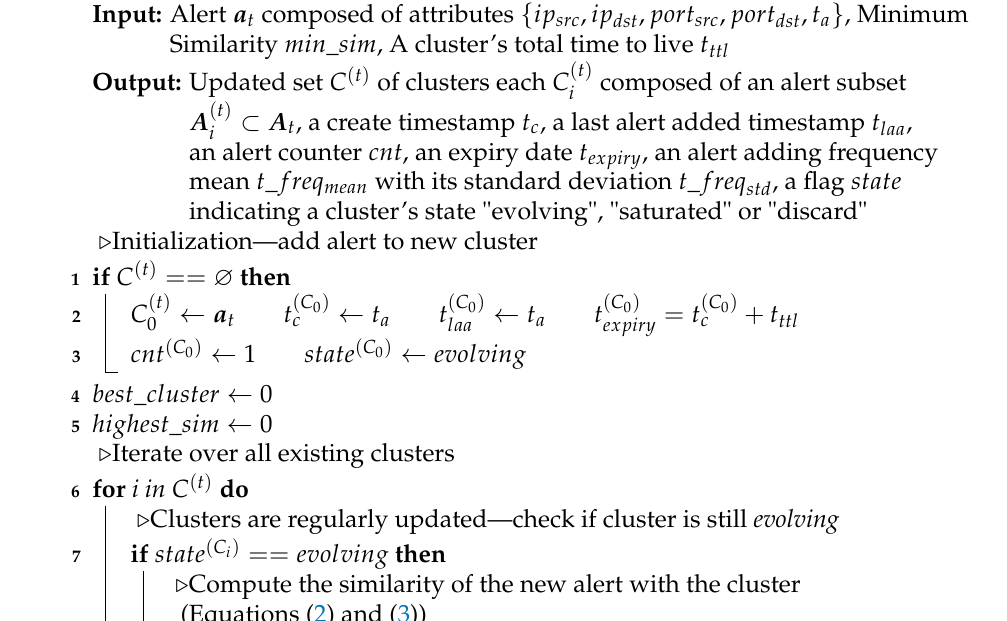
Algorithm 1: The Operation Principle of Streaming Alert Correlation / Clustering